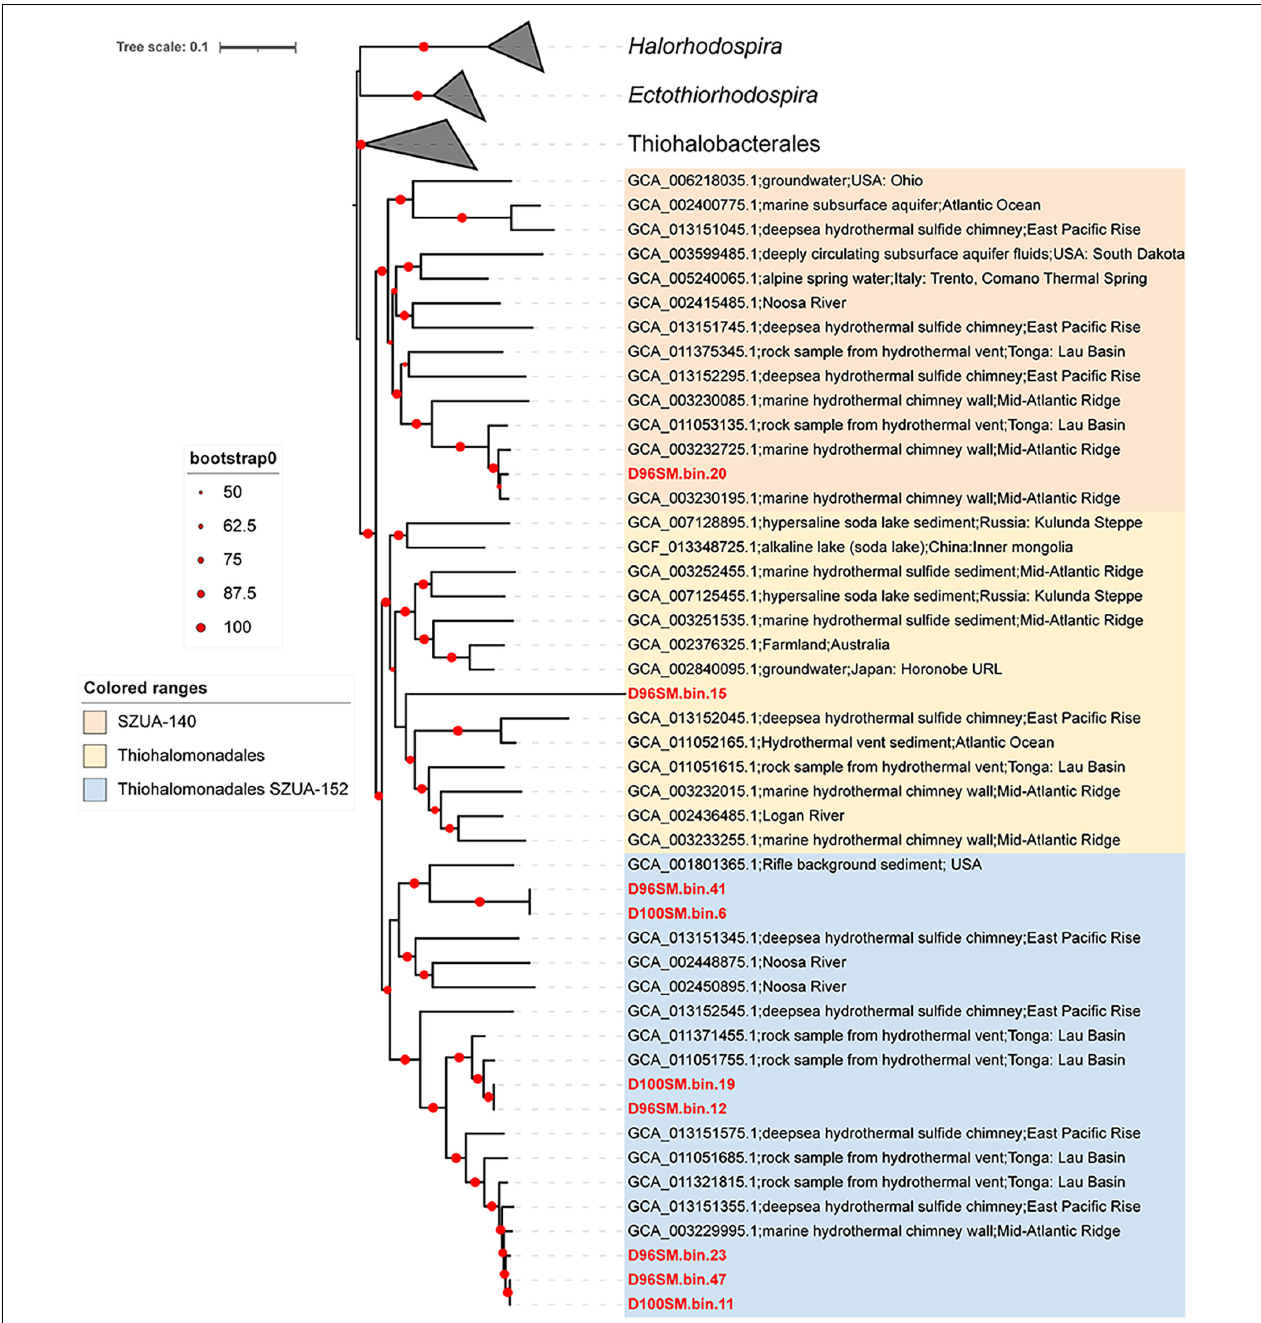
FIGURE 6 | Phylogenomics tree of Thiohalomonadales from the Southwest Indian Ridge (SWIR) hydrothermal chimney samples. The maximum likelihood (ML) phylogenomics tree was constructed using concatenated alignment of 43 conserved proteins extracted from Thiohalomonadales MAGs and reference genomes from GTDB database. The information of the MAGs in red from this study is shown in Supplementary Table 4